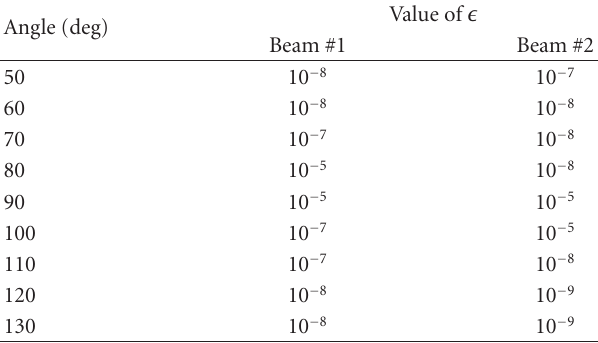
Table 2: Value of (cid:2) for each angle of